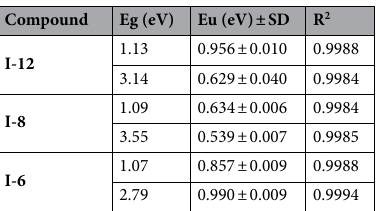
Table 2. Values of the energy gap, Eg, and Urbach energy, E U , of I-6, I-8, and I-12 derivatives in liquid crystal phase designed at 140 °C.